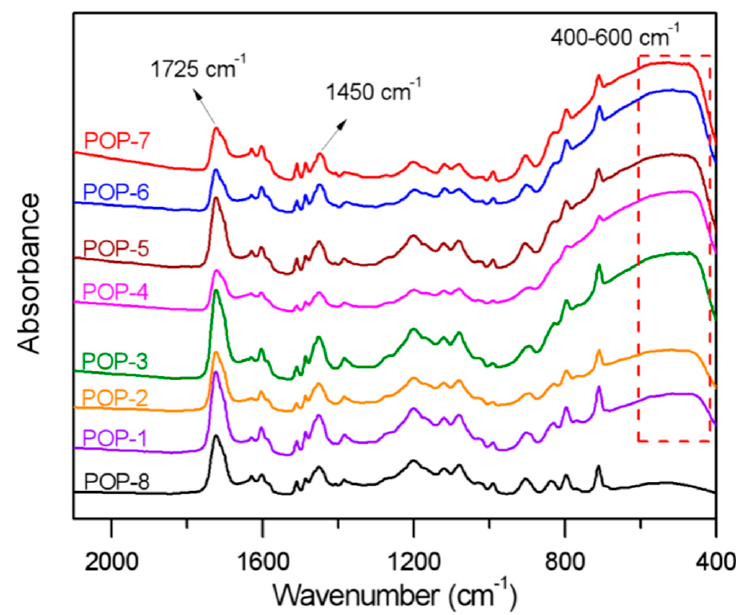
Figure 3. IR spectra of the prepared TiO2/POP particles.